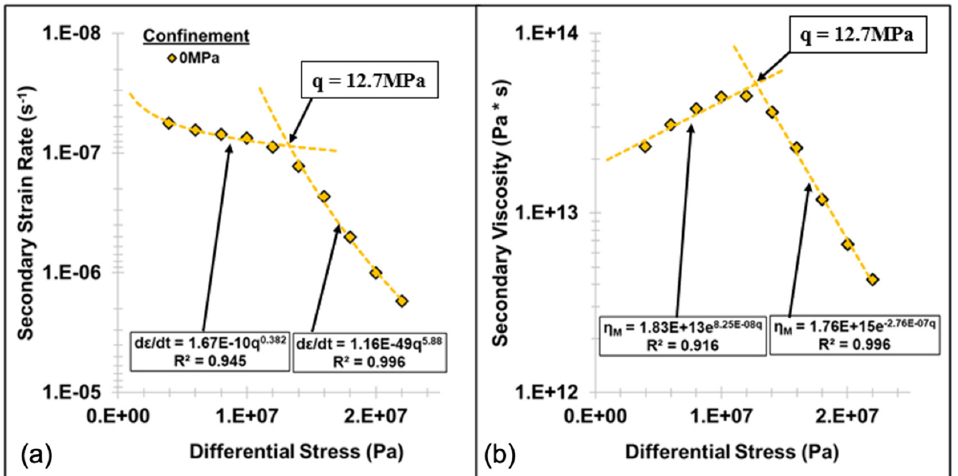
Figure 8. ( a ) Secondary strain rate and ( b ) Maxwell viscosity versus applied stress for rock salt from [92].